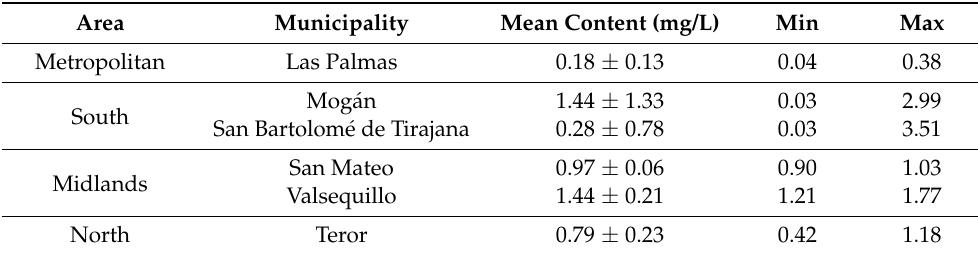
Table 4. Mean concentrations, standard deviations (SD), maximum and minimum values of fluoride in water samples from Gran Canaria.